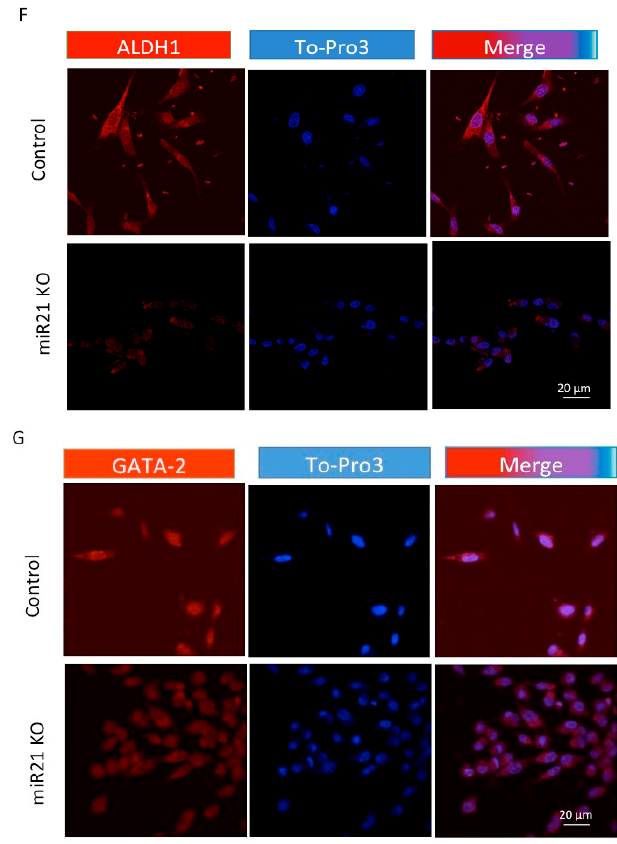
Figure 5. The silencing of miR-21 reduced the mesenchymal phenotype of MDA-MB-231 cells. ( A ) Protein levels of epithelial and mesenchymal markers were tested by Western blotting. β -actin was used as a loading control. The densitometry graph represents protein expression levels of band intensities obtained from at least three independent experiments. The relative band intensities of each sample were calculated by normalizing against β -actin. Each data point represents average ± SD. **** p < 0.0001. ( n = 3) ( B – E ). Immunofluorescence assay was performed to show E-cadherin levels and localization, Snail, Zeb-1, and vimentin (green). ( F – G ) Cancer stem cell markers ALDH1, GATA2 expressions (red), and localizations were assessed by using immunofluorescence in MDA-MB-231 wt and miR-21 KO cells. ToPro3 (blue) was used for nuclei. KO2 immunofluorescence results were shown as a representative to compare to wt ( n = 3), scale bar 20